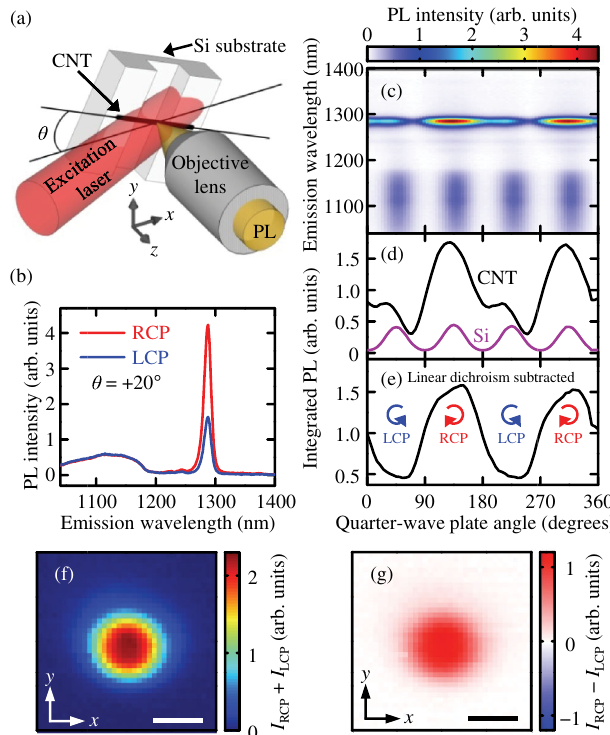
FIG. 1 (color online). (a) A schematic of the experimental geometry. The substrate is parallel to the xy plane, and the optical collection path through the objective lens is along the z axis. (b) PL spectra of an individual nanotube for excitation with RCP (red, upper curve) and LCP (blue, lower curve). (c) PL spectra as a function of the quarter-wave plate angle. The laser is linearly polarized along the y axis before the wave plate. (d) Integrated PL intensity from CNT (black) and Si (purple) as a function of the quarter-wave plate angle. The spectral integration window for the CNT is centered at 1290 nm and has a width of 40 nm, while Si PL has been integrated from 1040 nm to 1200 nm. (e) Linear dichroism for CNT PL is extracted by fitting the data in (d) by two sinusoidal functions with periods of 90° and 180°, and the component with 90° periodicity has been subtracted. (f) and (g) Sum and difference images, respectively, of integrated CNT PL for excitation with RCP and LCP. The excitation laser spot is fixed, and the collection spot is scanned to obtain the images. Scale bars are 2 μ m. For (b-g), λ ¼ 780 nm and P ¼ 26 mW are used for the excitation. The nanotube is at θ ¼ þ 20 ∘ and has a suspended length of 1 . 3 μ